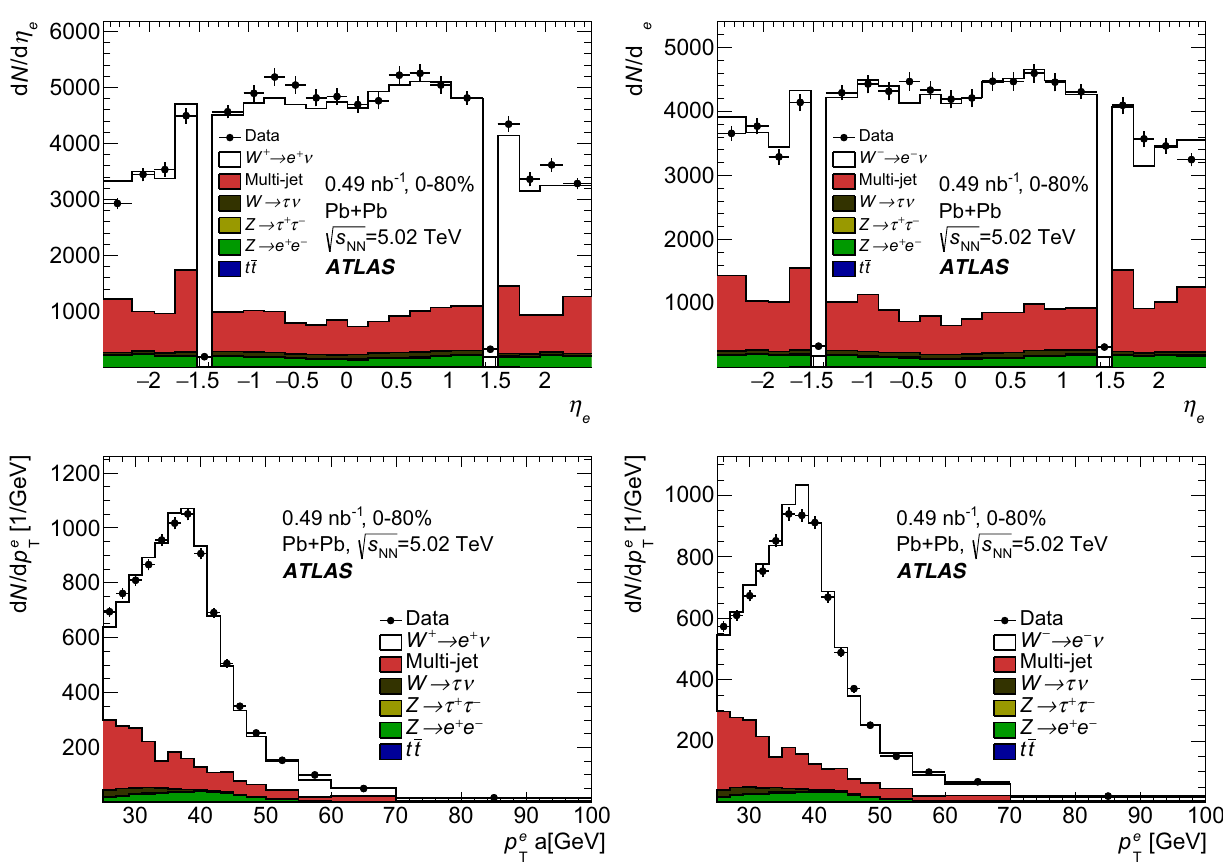
Fig. 2 Detector-level distributions of W + (left) and W − (right) event candidates decaying in the electron channels after all selection require- ments as a function of the electron pseudorapidity (top) and transverse momentum (bottom). The contributions of EW and top-quark back- grounds are normalised according to their expected number of events